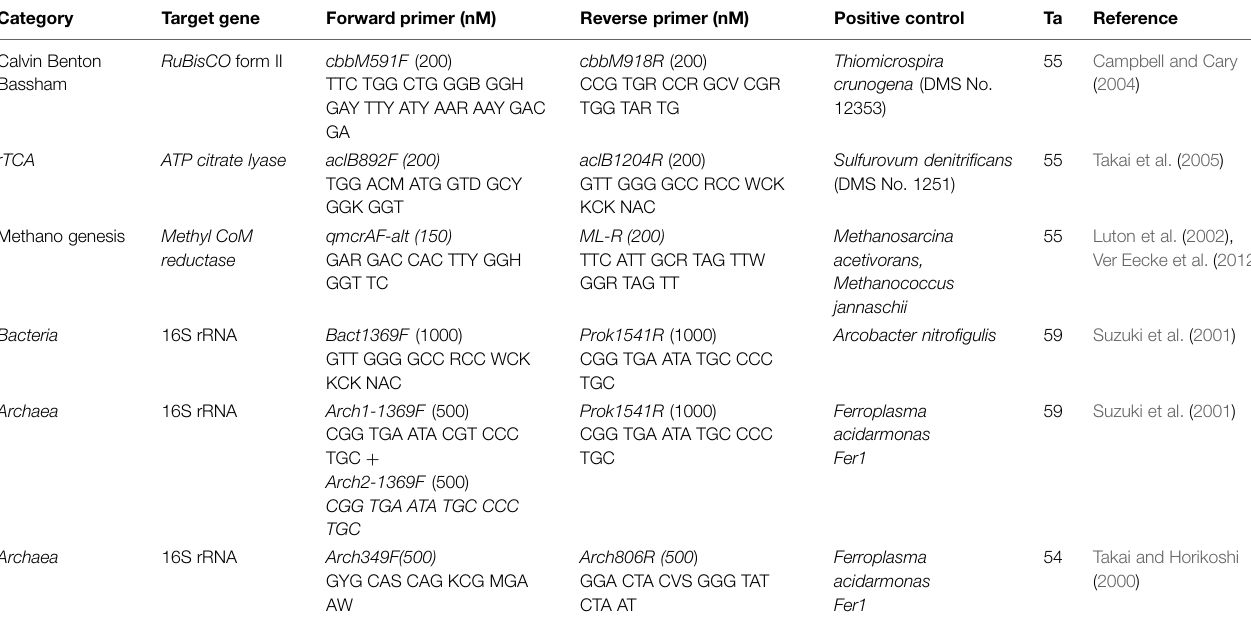
TABLE 2 | Oligonucleotide primers and conditions used in this study for quantitative PCR